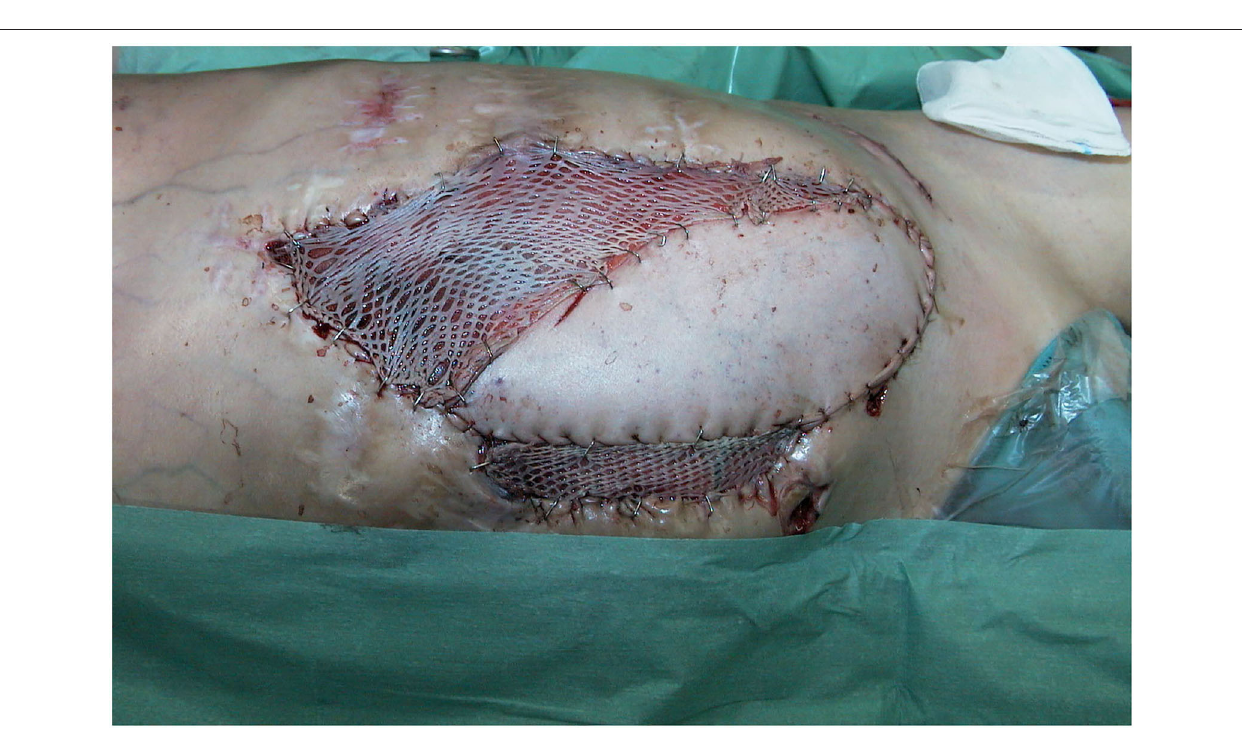
Frontiers in Surgery |